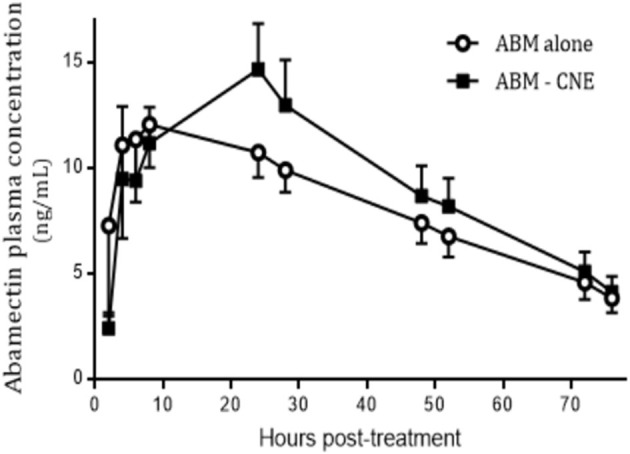
Plasma concentration profiles of abamectin (ABM) after its oral administration at 0.2 mg/kg (recommended dose) either alone or coadministered with R-carvone (R-CNE) (four doses of 100 mg/kg each) to lambs (n = 8) infected with resistant nematodes. Profile is shown up to 70 h posttreatment to focus on the effect of R-CNE on ABM absorption phase.